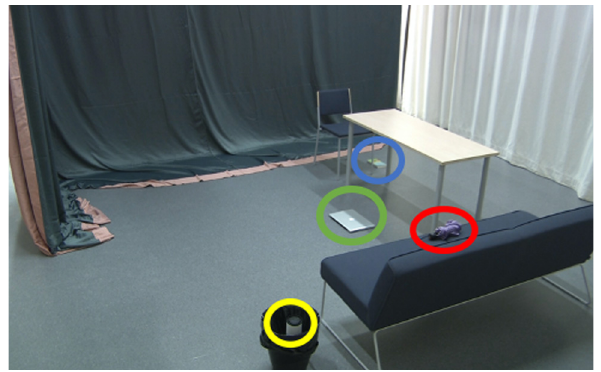
Figure 5: The room setting in the fi nal phase of the experiment.